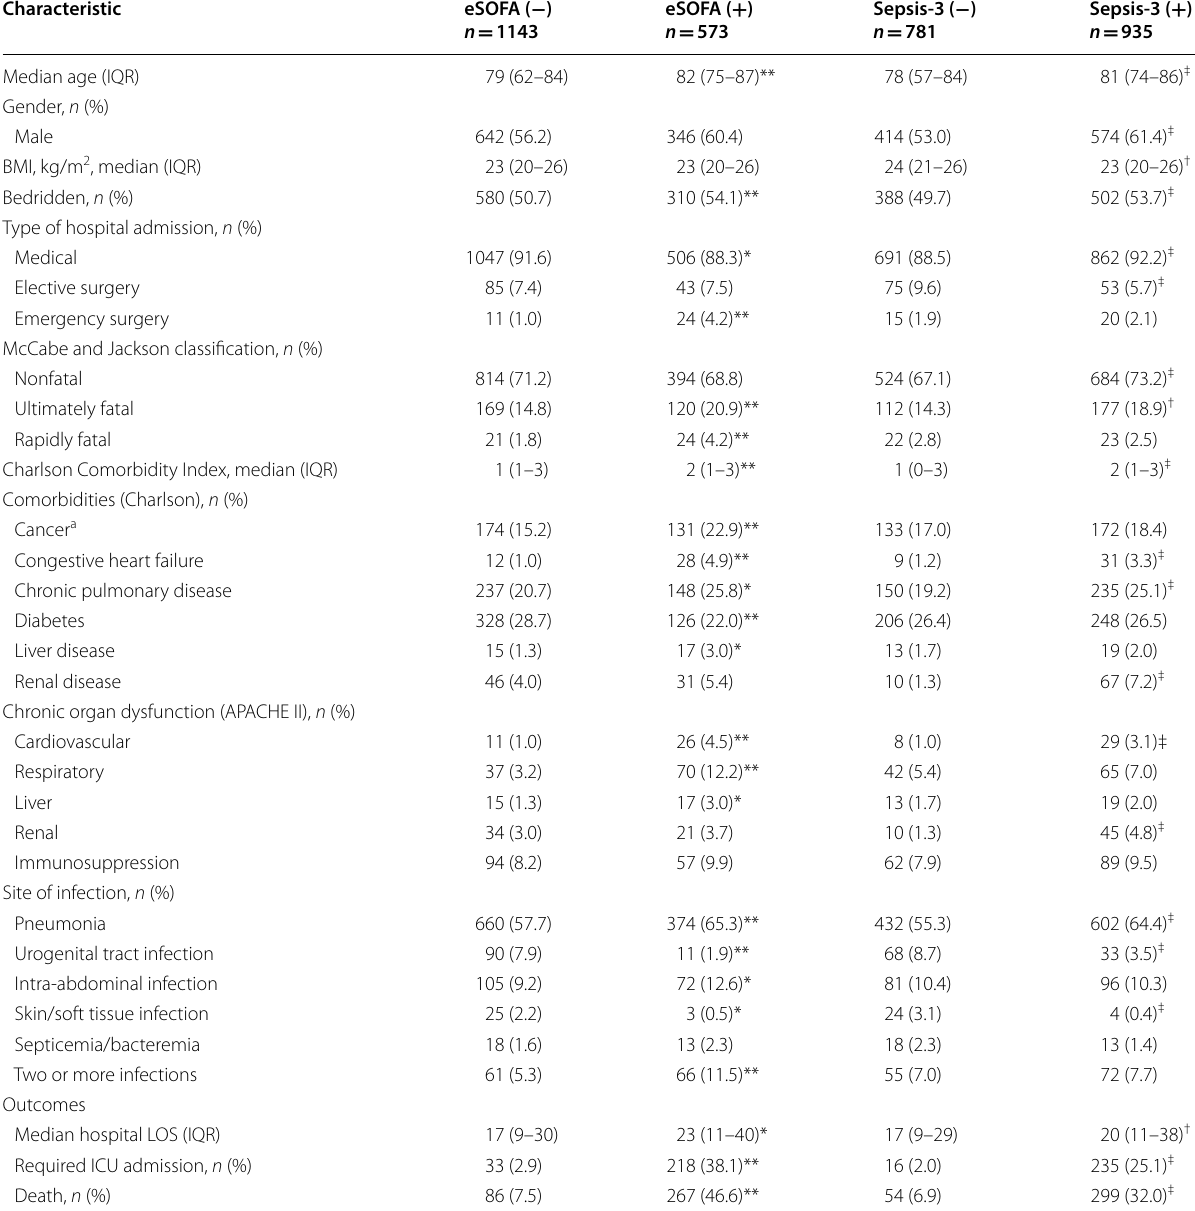
IQR interquartile range, BMI body mass index, LOS length of stay * p < 0.05, ** p < 0.01, compared with eSOFA ( a Cancer includes solid tumor with or without metastases, leukemia, and